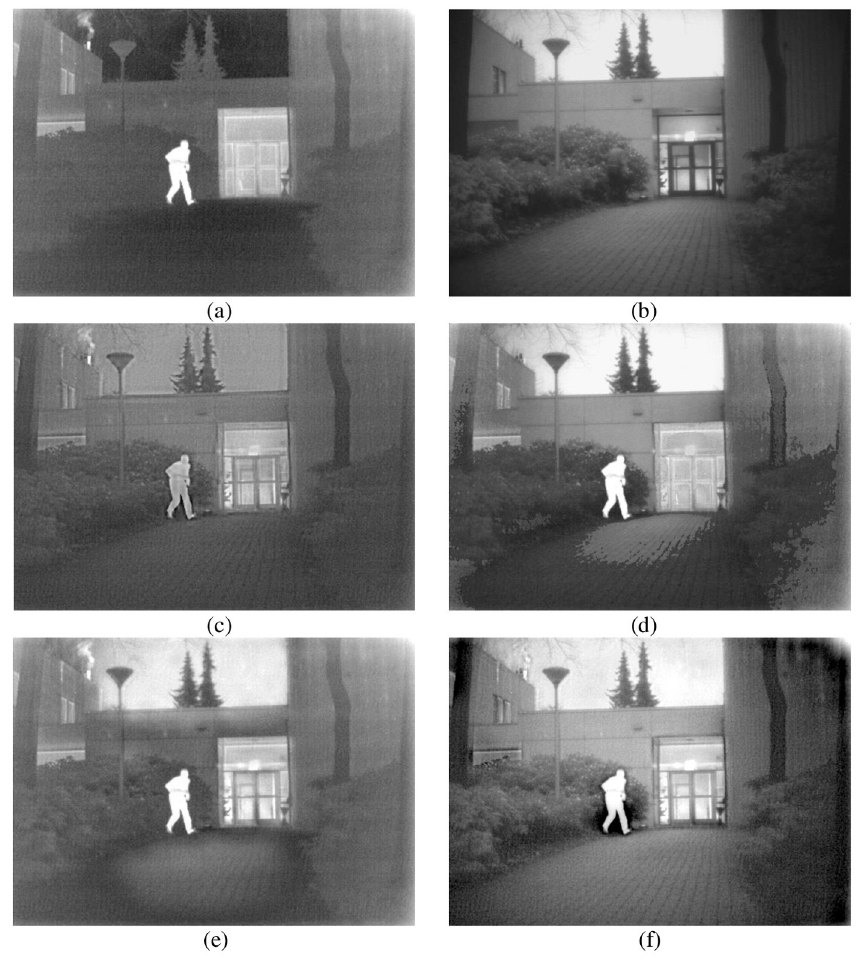
Fig 8. The third group of experimental results. (a) IR image, (b) VI image, (c) DWT, (d) PCNN, (e) NSCT_PCNN, (f) Proposed method.